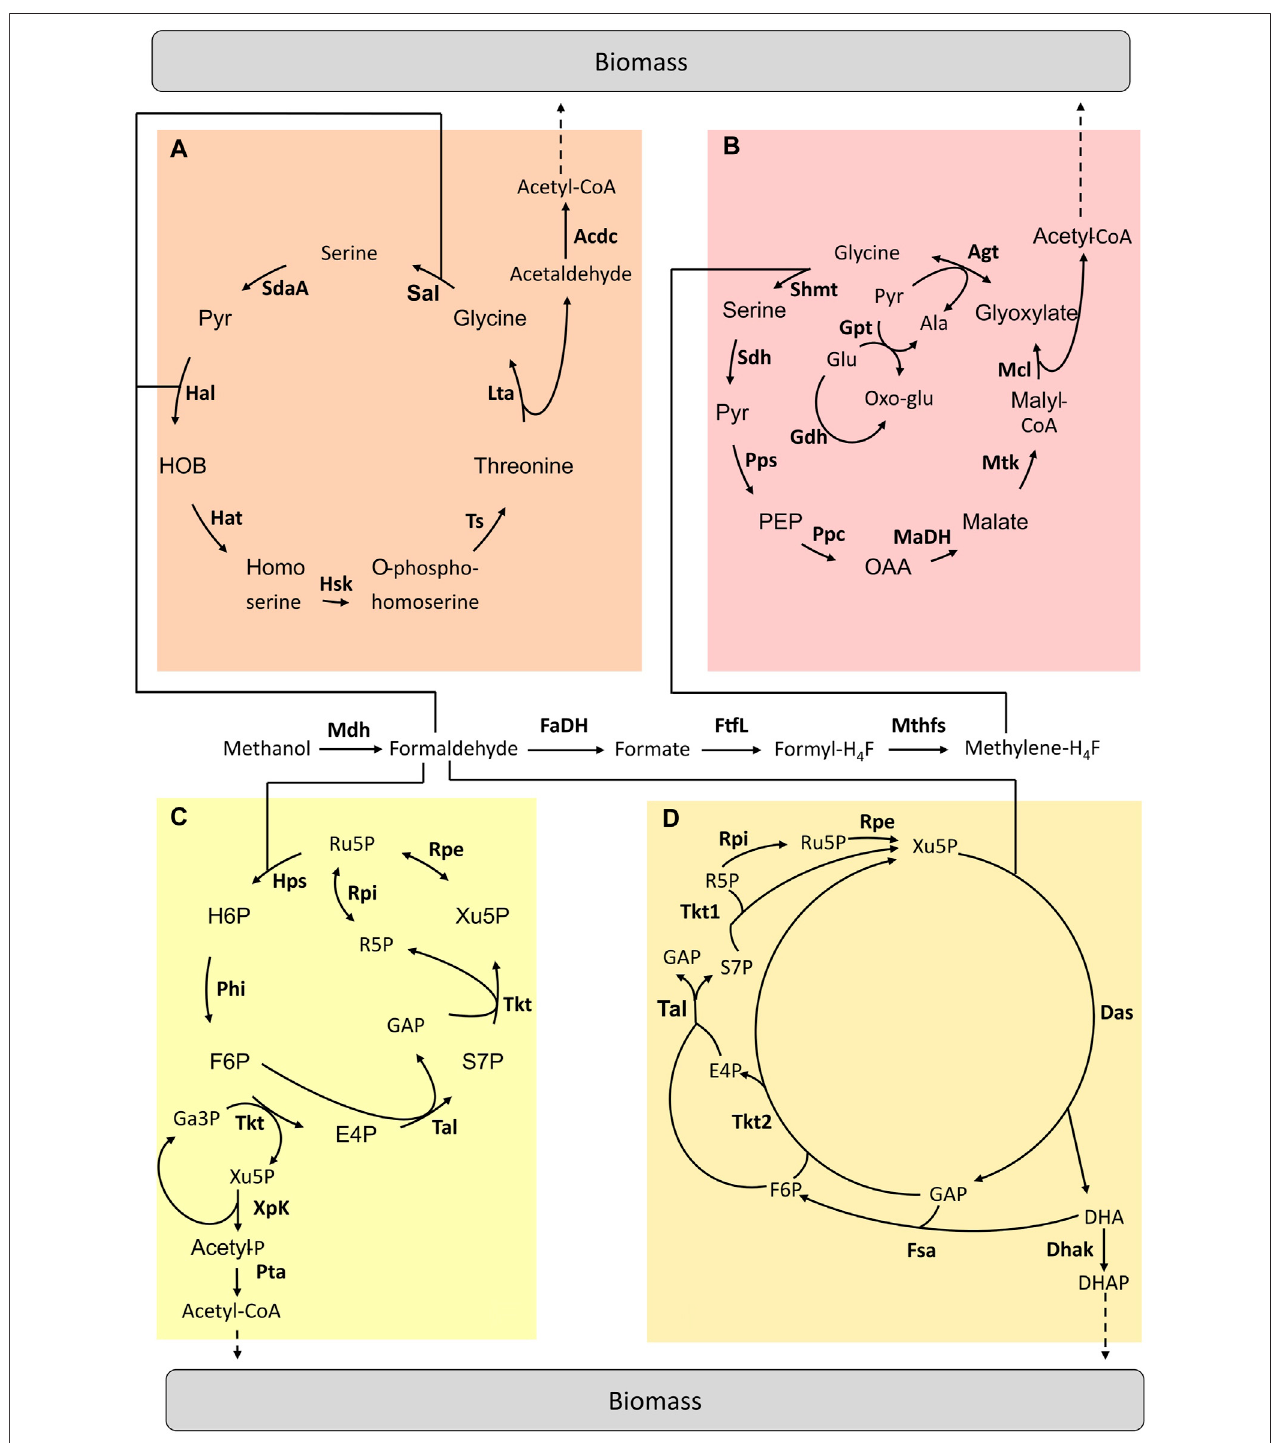
FIGURE2| HybridpathwaysimplementedforC1-assimilation. (A) Homoserinecyclepathway (B) Modi fi edserinecyclepathway (C) Methanolcondensationcycle pathway (D) HybridMdh-Daspathway.Adaptedfrom(Tuyishime,etal.,2020).Enzymesarewritteninbold.Acdc,acetaldehydedehydrogenase;Agt,Alanine-glyoxylate aminotransferase; Dhak, DHA kinase; FaDH, formaldehyde dehydrogenase; FtfL, formate-H 4 F ligase; Fsa, Fructose-6-aldolase; Gdh, glutamate dehydrogenase; Gpt; Glutamate-pyruvate transaminase; Hal, 4-hydroxy-2-oxobutanoate aldolase; Hat, 4-hydroxy-2-oxobutanoate aminotransferase; Hsk, homoserine kinase; Lta, threonine aldolase; MaDH, malate dehydrogenase; Mcl, malyl-CoA lyase; Mdh, methanol dehydrogenase; Mthfs, methylene-H 4 F dehydrogenase; Mtk, malate thiokinase; Ppc, phosphoenolpyruvate carboxylase; Pps, phosphoenolpyruvate synthetase; Rpe, ribulose-3-phosphate epimerase; Rpi, ribose-5-phosphate